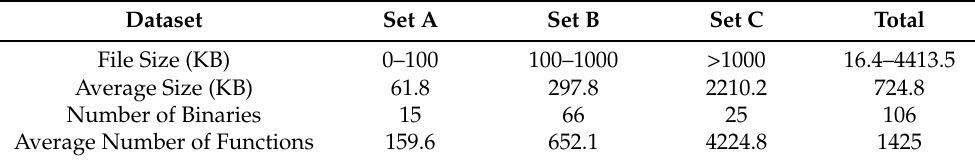
Table 1. Nix binary dataset used for evaluating TPL detection.